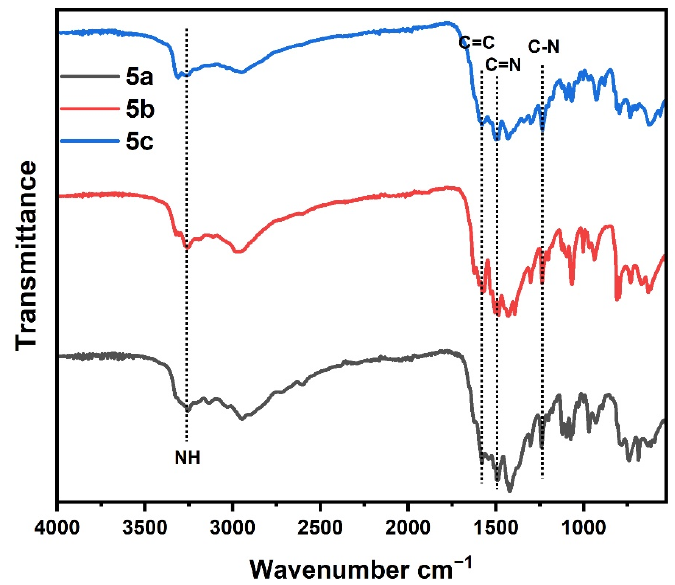
Figure 1. FT-IR spectrum of samples (5a-c).